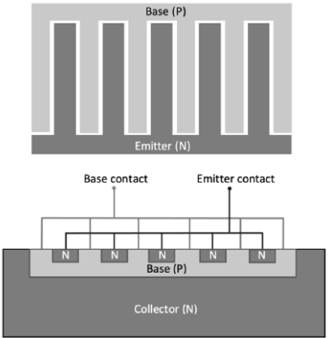
Figure 1. A typical interdigitated structure of a bipolar junction transistor. EL spectra were obtained by using a grating spectrometer Optometrics Corp. DMC1-